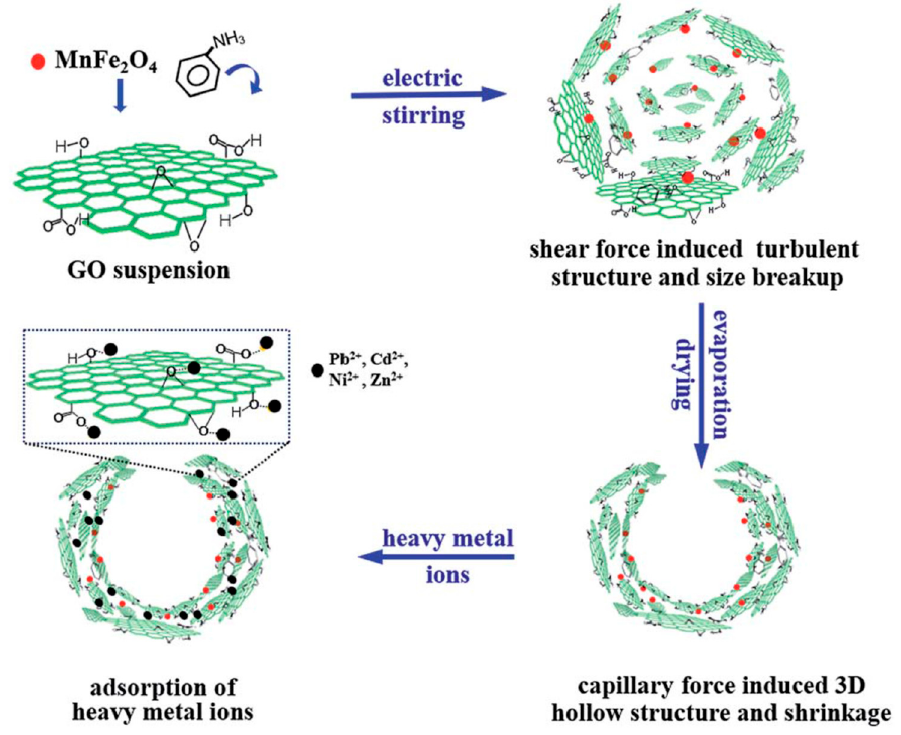
Figure 5. Scheme illustrating the self-assembly synthesis of a GO / MnFe 2 O 4 motor for the removal of heavy metal ions by shearing force driven breakup combined with capillary force induced shrinkage. Reproduced from Reference [32] with permission.